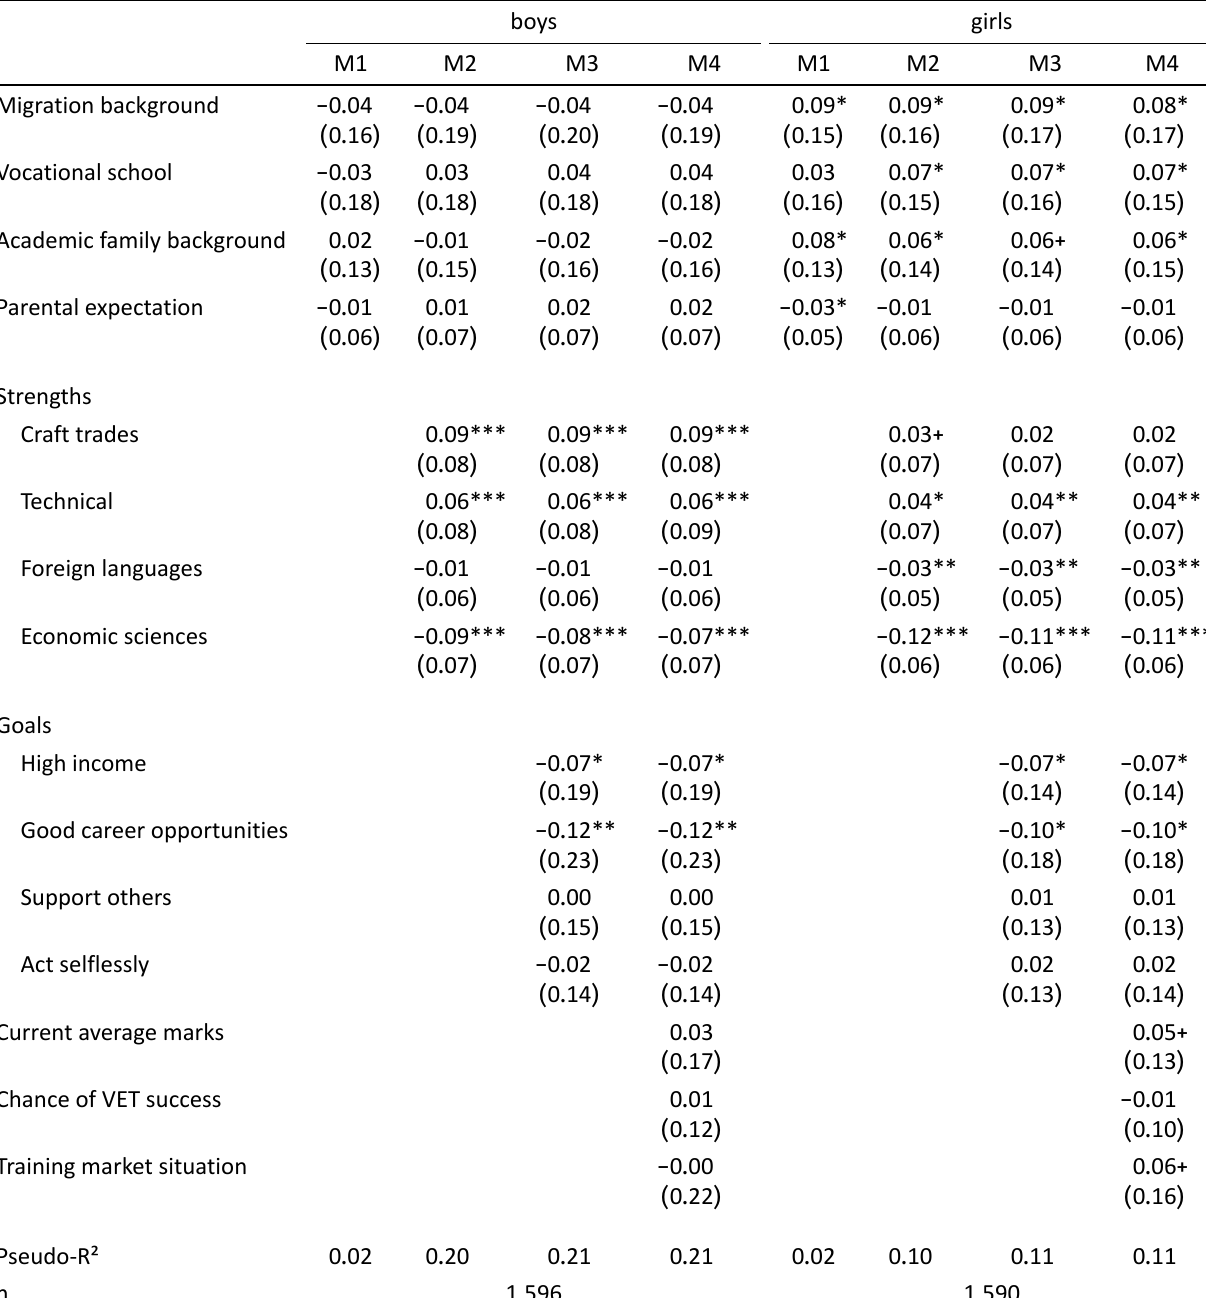
Table 2. Determinants of aspiration for non‐HEEC